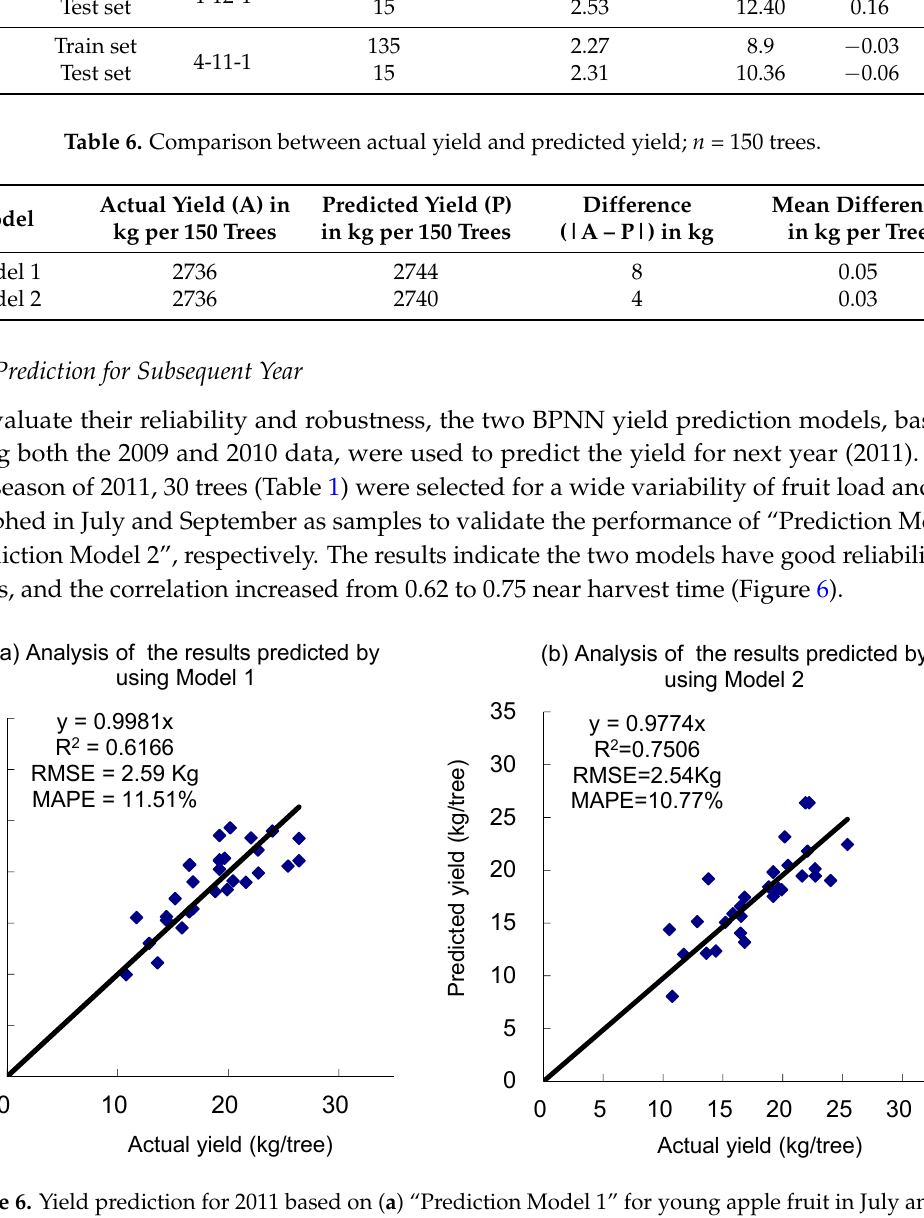
Table 7. The model structure and the evaluation of model performance which was developed based on samples of 2012 for cv. “Pinova”.